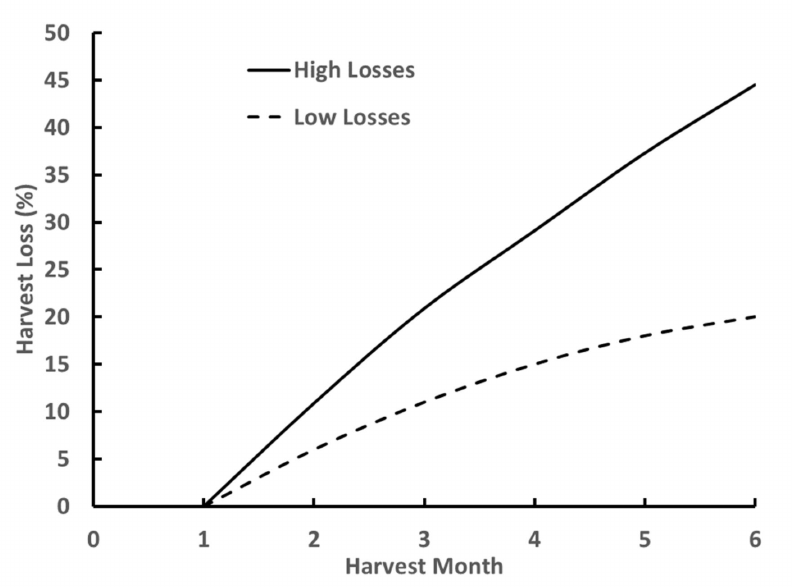
Figure 3. Harvest loss factors as a function of harvest date. Harvest months are (1) September to (6) February.